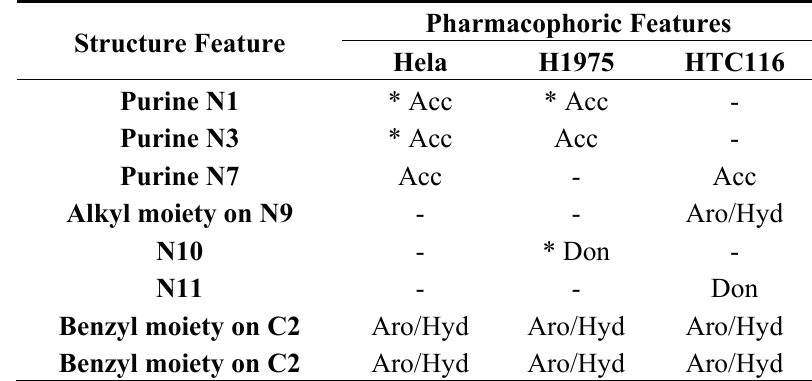
Table 3. Pharmacophoric and structure features of the training set for each purine derivatives on cancer cell